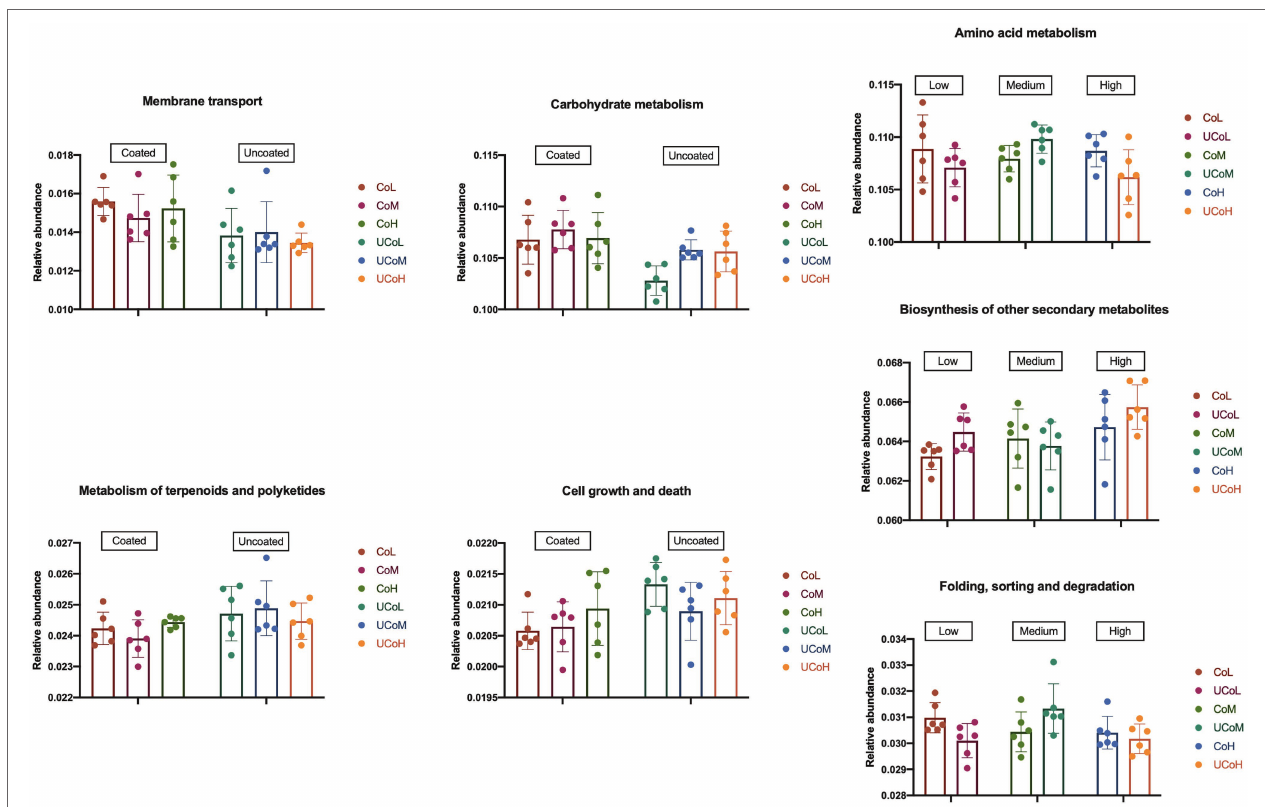
FIGURE 5 | Comparison of microbiota function related to Kyoto Encyclopedia of Genes and Genomes (KEGG) pathway at level 2. CoL, 300 mg/kg of coated trace mineral treatment; CoM, 500 mg/kg of coated trace mineral treatment; CoH, 1,000 mg/kg of coated trace mineral treatment; UCoL, 300 mg/kg of uncoated trace minerals treatment; UCoM, 500 mg/kg of uncoated trace minerals treatment; and UCoH, 1,000 mg/kg of uncoated trace minerals